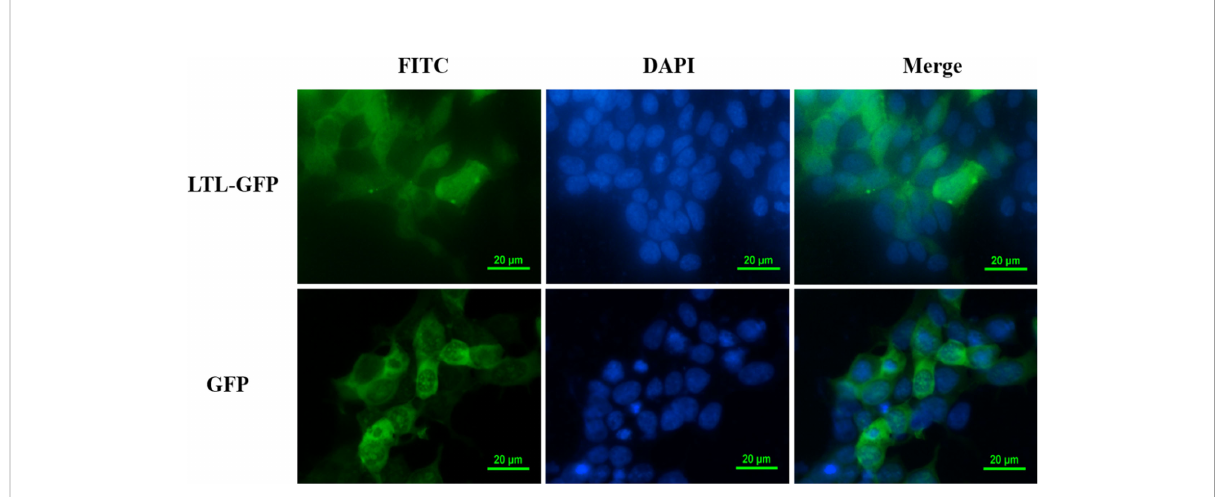
FIGURE 8 Subcellular localization analysis of OppLTL-EGFP fusion proteins expressed in HEK293T cells by transfection of OppLTL-EGFP plasmid fl uorescence